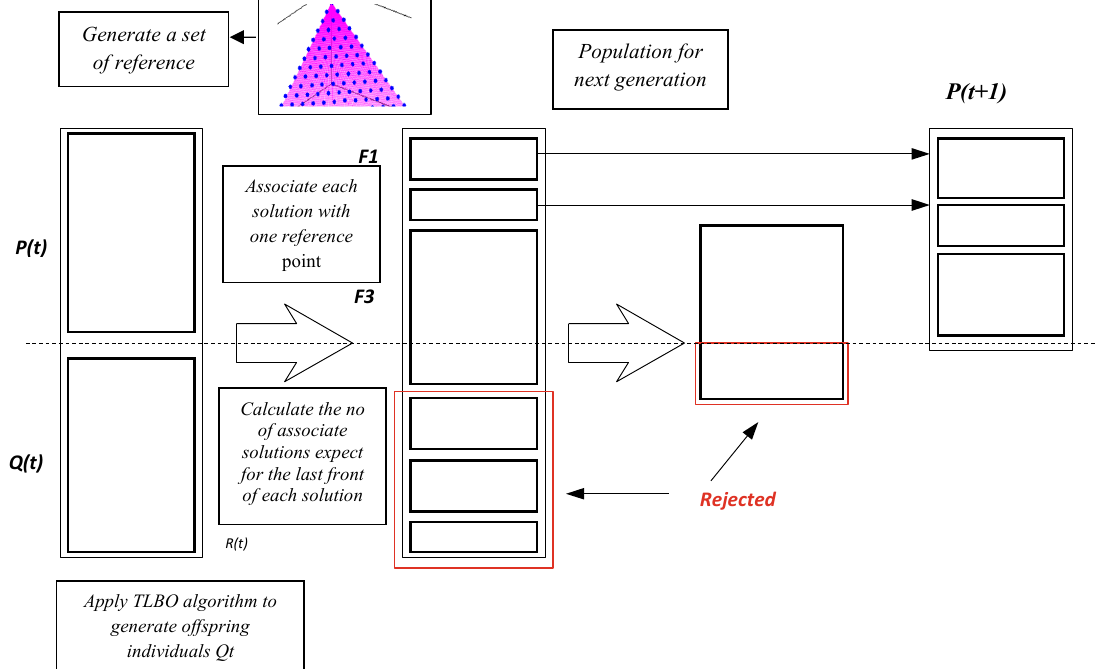
Fig. 4. Detailed process to make the ( t +1) th population from t th